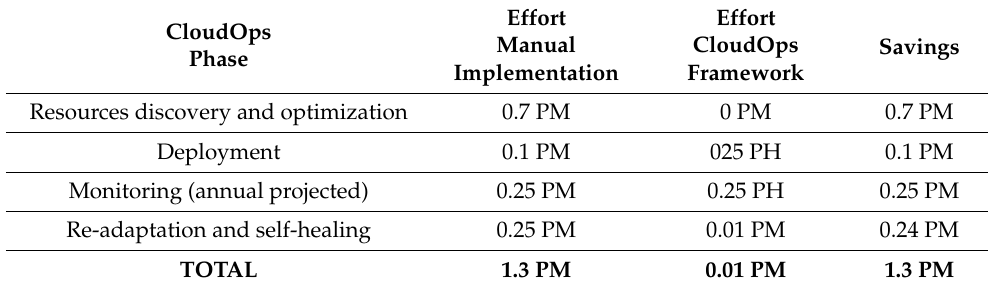
Table 3. Estimation of the savings provided by the Cloud Ops framework in the e-health scenario. Effort Effort CloudOps CloudOps Manual Savings Phase Framework Implementation Resources discovery and optimization 0.7 PM 0 PM 0.7 PM Deployment 0.1 PM 025 PH 0.1 PM Monitoring (annual projected) 0.25 PM 0.25 PH 0.25 PM Re-adaptation and self-healing 0.25 PM 0.01 PM 0.24 PM TOTAL 1.3 PM 0.01 PM 1.3